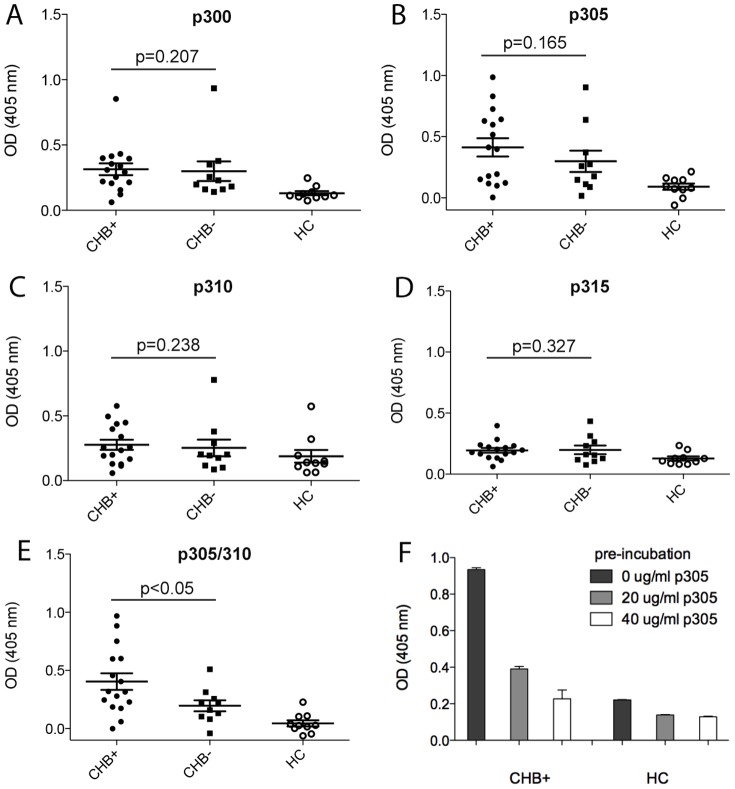
Reactivity in CHB pregnancies is specific for the p305 peptide of α1G and can be blocked.Four overlapping 15aa peptides, and one 20aa peptide were selected to further characterize maternal sera reactivity to α1G in mothers with CHB pregnancies (CHB+) compared to mothers with unaffected pregnancies (CHB−). Reactivity to (A) peptide p300 (aa300–314), (B) p305 (aa305–319), (C) p310 (aa310–324), (D) p315 (aa315–329) demonstrate that sera from mothers with pregnancies affected by CHB (CHB+), have significantly higher p305 antibody levels compared to unaffected (CHB−) pregnancies (p<0.05). Although p305 (aa305–319) had the highest reactivity, a longer peptide combining p305 and p310 designated p305/310 (aa305–24) demonstrated a significant difference between CHB+ and CHB− maternal serum (E). Pre-incubation of one CHB+ maternal sera, and one healthy control (HC) sera with increasing concentration (0, 20, 40 µg/ml) of peptide p305 (aa305–319) demonstrates that the reactivity of sera is specific for this peptide and can be blocked (F). Error bars indicate mean ± SE.